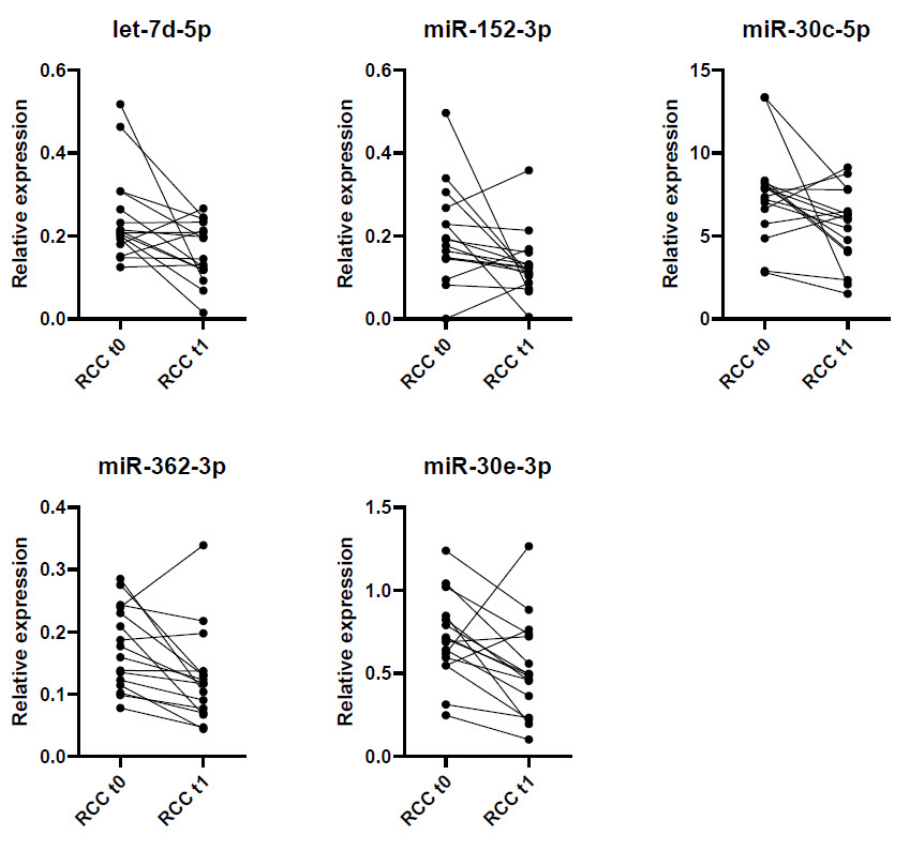
Figure 7. Relative expression of the five dysregulated miRNAs ( let-7d-5p , miR-152-3p , miR-30c-5p , miR-362-3p and miR-30e-3p ) in ccRCC patients before (t 0 ) and after (t 1 ) surgery. Table 3. Correlation among dysregulated miRNAs in ccRCC patients before (t 0 ) and after surgery (t 1 ). Spearman correlation coefficients between two miRNAs are detailed. Significant p -values are depicted in bold.